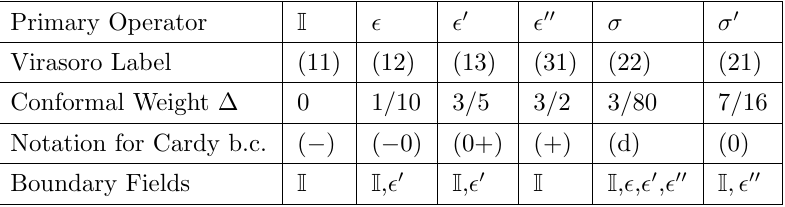
Table 3. Table of notation for the tricritical Ising model.